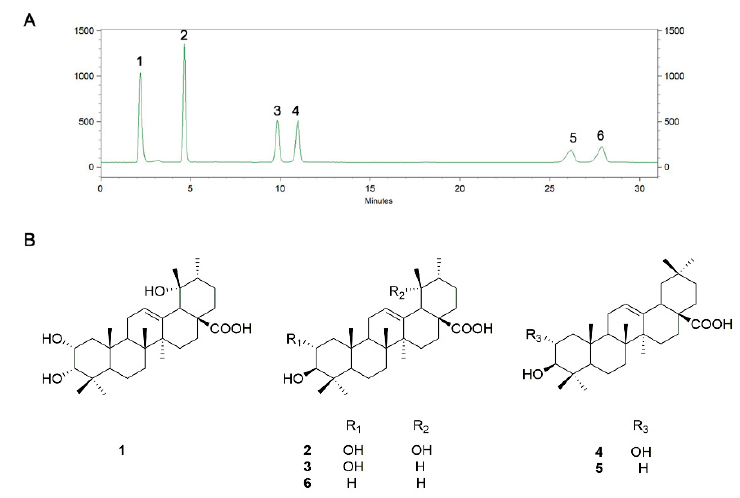
Figure 1. ( A ) Representative chromatograms of triterpene acids (TAs) and ( B ) chemical structures of six dominant TAs. Table 1. Concentrations of six TAs analyzed by high-performance liquid chromatography– evaporative light scattering detection (HPLC-ELSD) (n = 3).